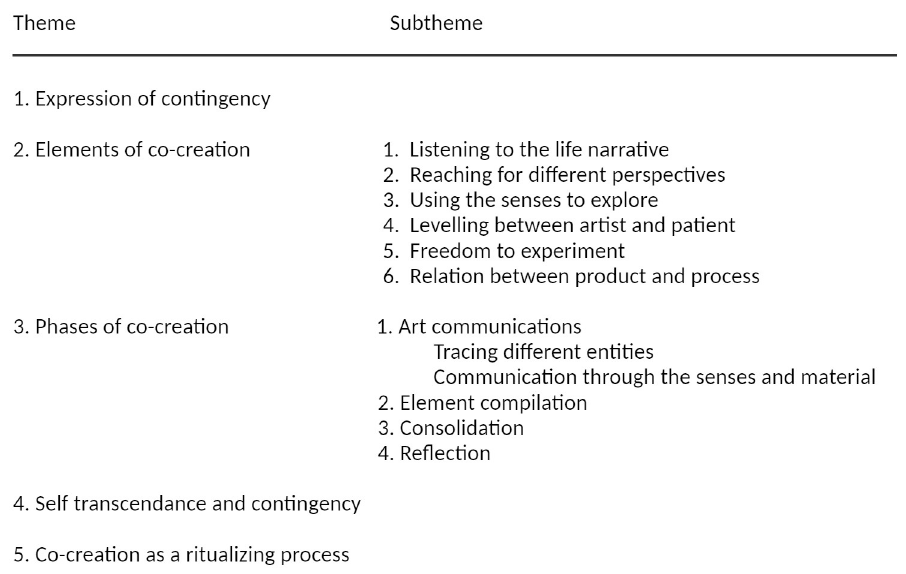
Fig 2. Final template. The subsequent phases of co-creation are numbered to indicate their temporal